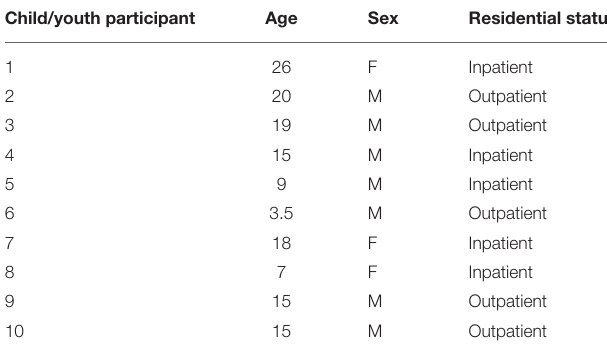
TABLE 1 | Child/youth participant